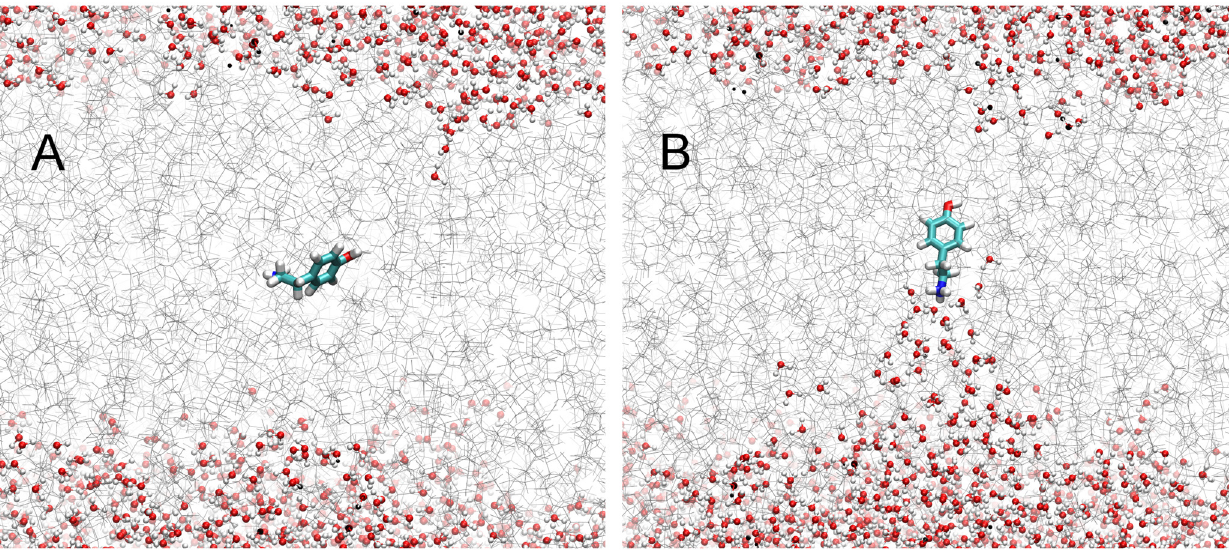
Fig 3. Snapshots of the tyramine/POPC systems, with tyramine near the bilayer center. (A) The unprotonated tyr permeates without any water accompaniment, and with no obvious orientational preference. (B) The protonated tyr + never loses the solvation shell around the amine group, and as such always orients along its long axis with the phenolic group leading and the amine trailing. For a more detailed orientation analysis, see [